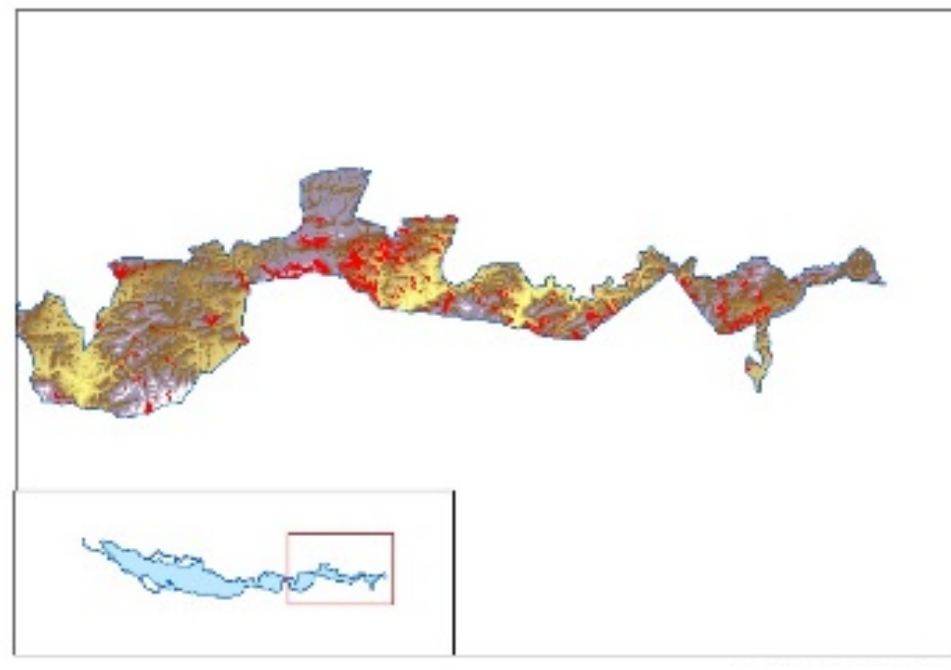
( c ) SCI: Sierra Morena. Mapped associations (habitat). Red: 5210 Figure 8. ( a – c ) 5210 Arborescent scrubs of Juniperus spp. ( Juniperion badiae ). (Sierra Morena, red polygons). Communities of Juniperus spp. ( oxycedrus group) are frequent on the Iberian Peninsula, in this case located in small patches on rocks. The patches that have been mapped are of great interest as they contain a high number of the endemic species found in this habitat. Longitude 4°4′16″ W, latitude 38°34′28″ N (Mestanza).